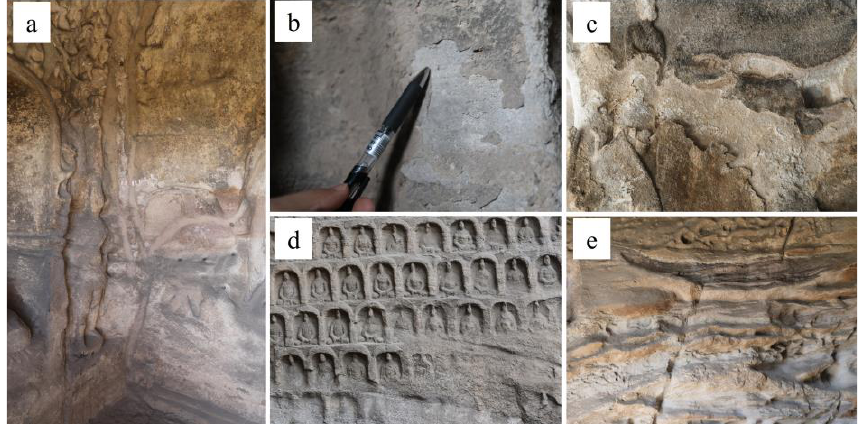
Figure 3. Typical weathering features in the Yungang Grottoes: ( a ) particulates deposition, surface discoloration, and salt efflorescence; ( b ) scaling of thin white crusts; ( c ) scaling of thick black crusts; ( d ) granular disintegration and surface recession; and ( e ) strip cutting.